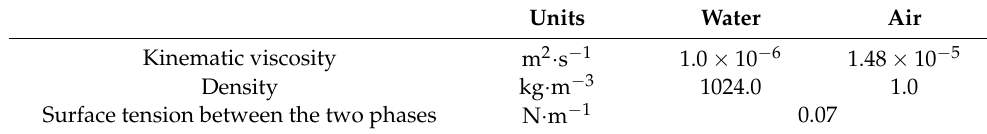
Table 1. Properties by phase.